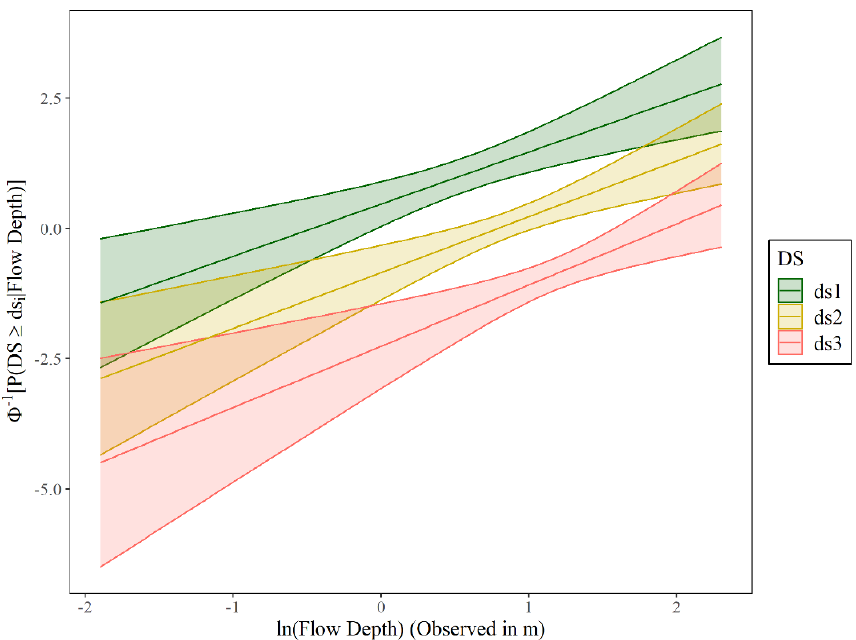
Figure 12. Probit functions fitted for each individual damage state to DB_Thailand2004 to assess whether the observed flow depth is an efficient descriptor of damage. The 90% confidence interval is